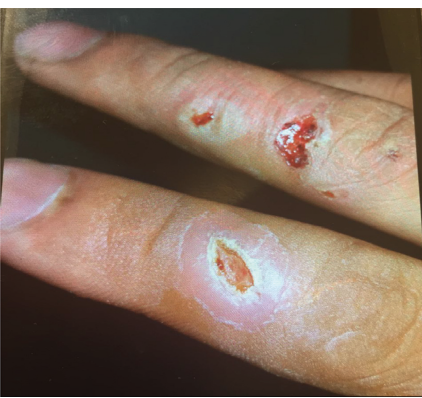
Figure 1: Ulcerative lesions before treatment.